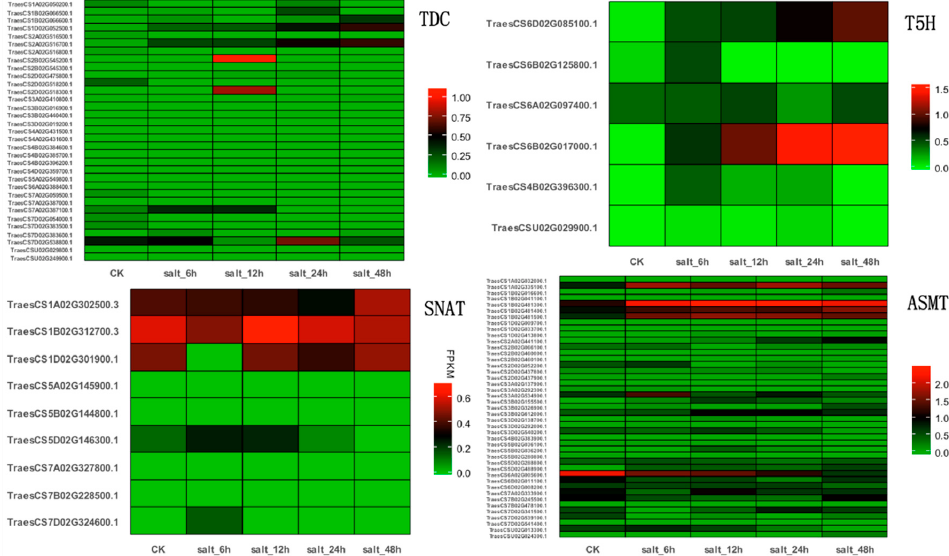
Figure 3. Expression profiles of TDC , T5H , SNAT , and ASMT genes in wheat under salt stress conditions. The red or green colors represent the higher or lower relative abundance of each transcript in each sample, respectively.